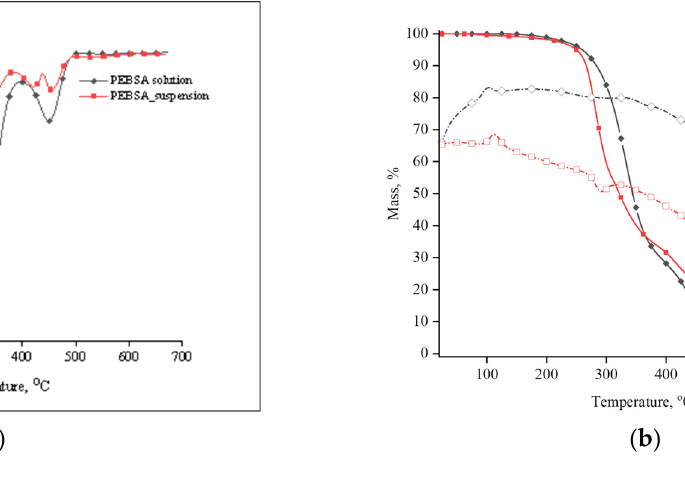
Figure 4. ( a ) DTG curve and ( b ) TG and DTA curve. Table 2. Thermal parameters of the PEBSA samples.